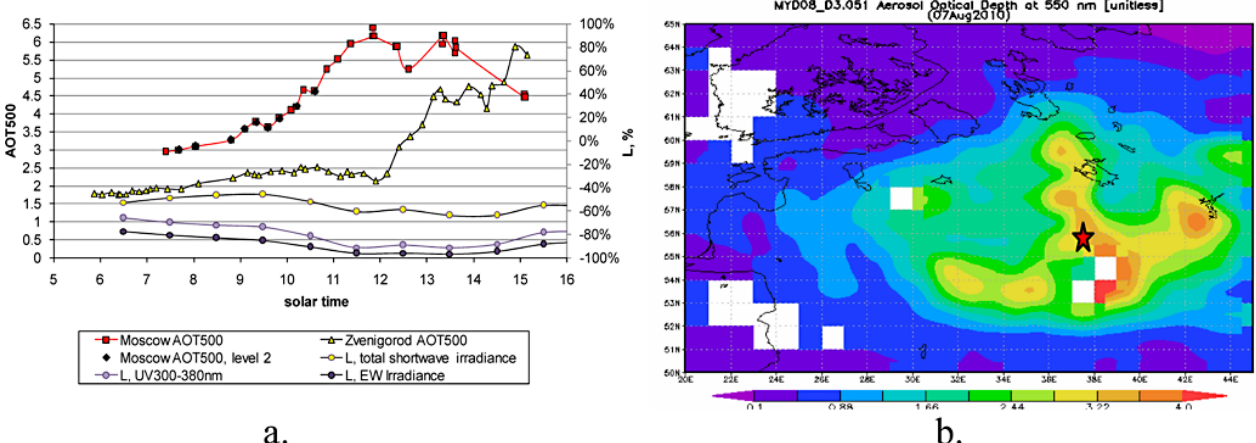
Fig. 5. Temporal variations of AOT500 in Moscow and Zvenigorod during 7 August 2010, when the highest aerosol loading was observed (a) ; spatial aerosol variation according to MODIS AOT550 data over the Moscow region for the same day (b) (from http://disc.sci.gsfc.nasa.gov/ giovanni). Aerosol properties during fire events observed in 2002, 2010 and in typical August conditions over the period 2001–2009. Meteorological observatory of Moscow State University. Real part of Imaginary part Factor of Single scattering refractive index, of refractive index, typical